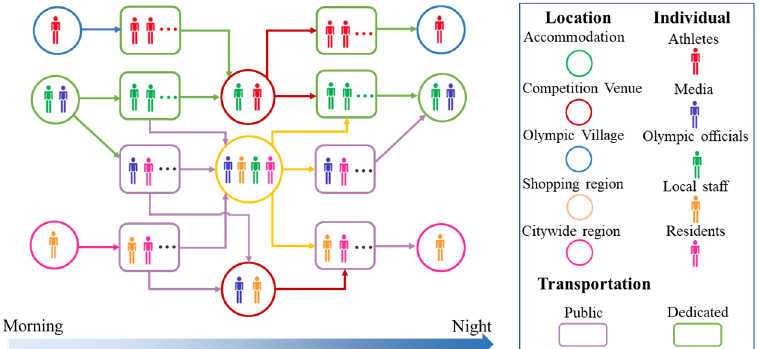
5 of 23 Table 2. The models used for different scenarios. Location